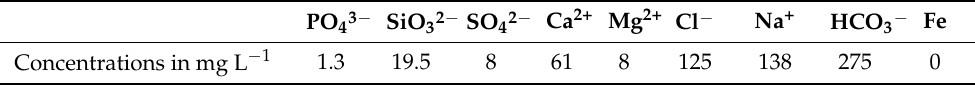
Table 1. SBGW composition used in this